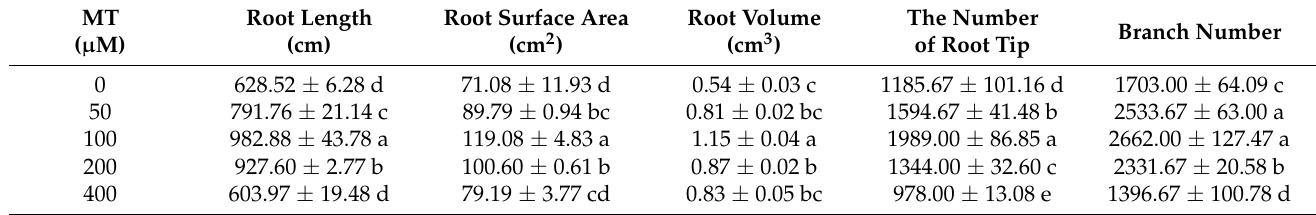
Table 1. Changes in root architecture of P. vulgaris under different MT treatments.